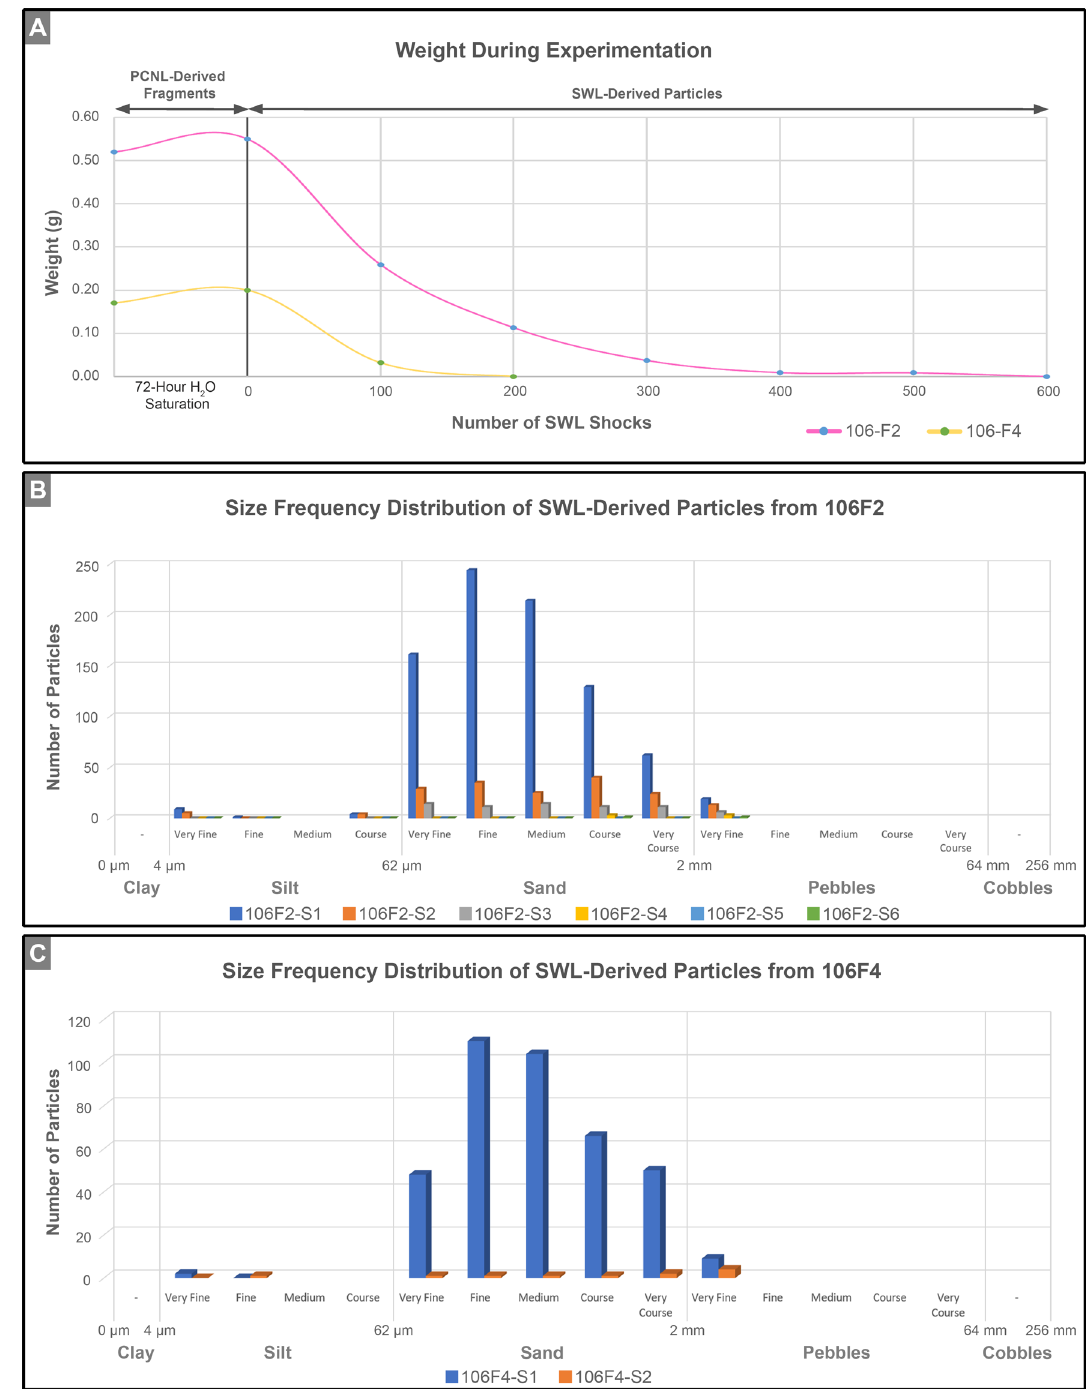
Figure 7. Weight changes and size frequency distributions of SWL-derived particle groups 106F2 and 106F4. ( A ) Change in weight of PCNL-derived fragments 106F2 and 106F4 after 72-h of H 2 O saturation prior to SWL experimentation, and weight changes during experimentation in SWL-derived particles during each incremental 100-shock treatment. Corresponding RL images and data are presented in Supplementary SFig. 4 and Supplementary STable 1. ( B ) Wentworth grain size frequency distribution of SWL-derived particles from 106F2 after six 100-shock treatments. ( C ) Wentworth grain size frequency distribution of SWL-derived particles from 106F4 after two 100-shock treatments. Corresponding data presented in Supplementary STable